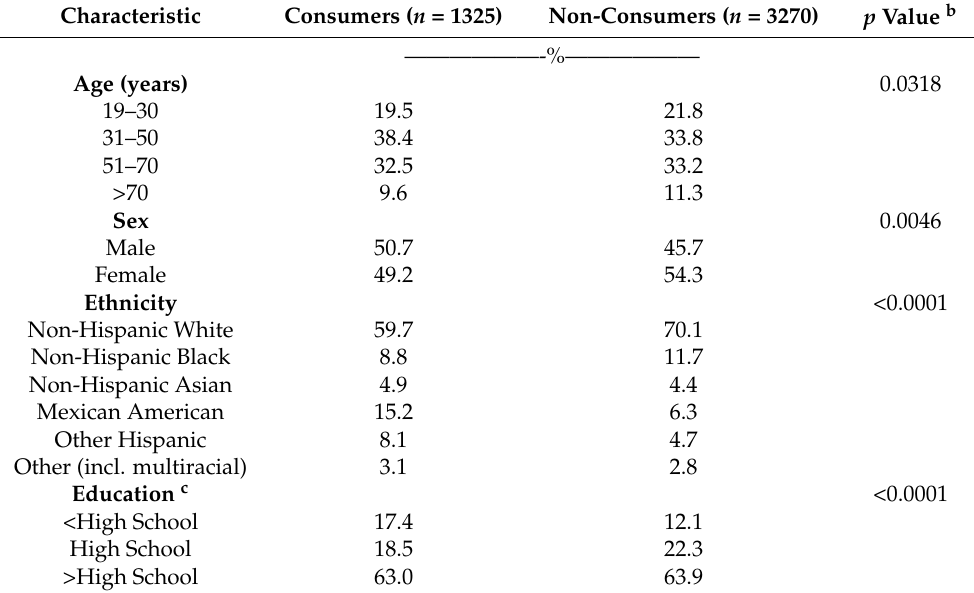
Table 1. Demographic characteristics of pulse a consumers and non-consumers based on 2-day intakes from NHANES,